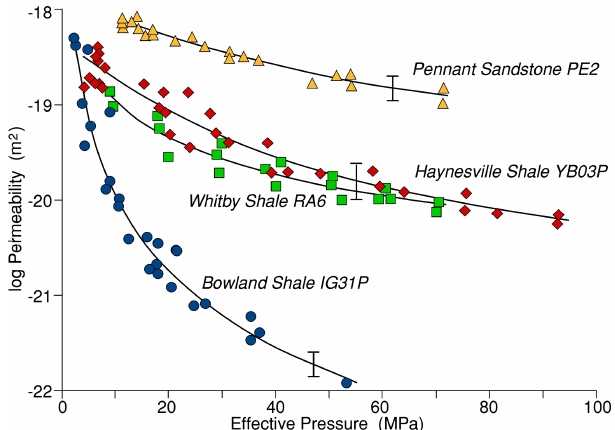
Figure 3. Matrix permeability of Pennant sandstone for flow normal to bedding and for Bowland and Haynesville shales for flow parallel to layering as a function of effective pressure ( P c − nP p ) over a wide range of pore pressures of argon gas. Data of Mckernan et al. (2017) for Whitby shale sample RA6 at a constant argon gas pore pressure of 25MPa are also shown for comparison. In each case data from the first pressure cycle up to the maximum effective pressure attained have been excluded. All rocks show permeability decreasing more slowly with effective pressure at higher effective pressures. Error bars are shown as estimated for the 10MPa pore pressure